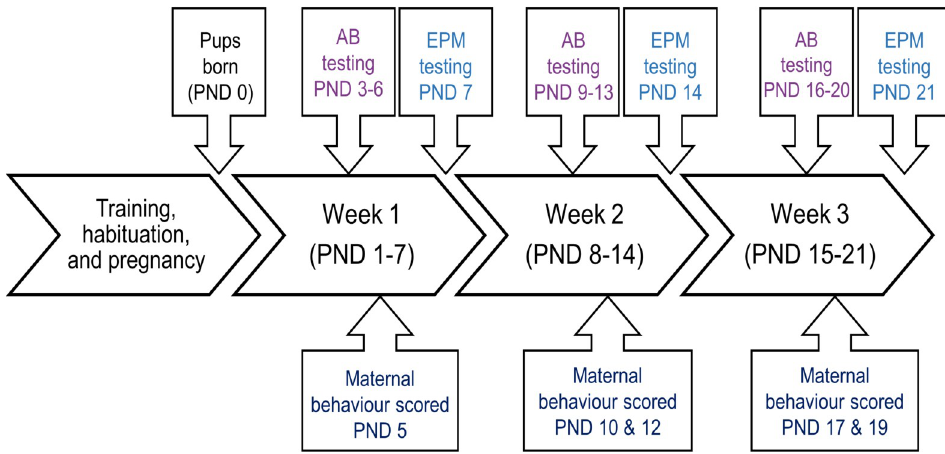
Fig 1. Experimental timeline for anticipatory behavior (AB), elevated plus maze (EPM) and maternal behavior data collection. “Training” refers to anticipatory behavior conditioning, while “habituation” refers to initial exposures to the experimenters, the elevated plus maze, and removal of lofts for rats in the no loft treatment. Time is shown relative to the day pups were born (Post-natal day, PND,